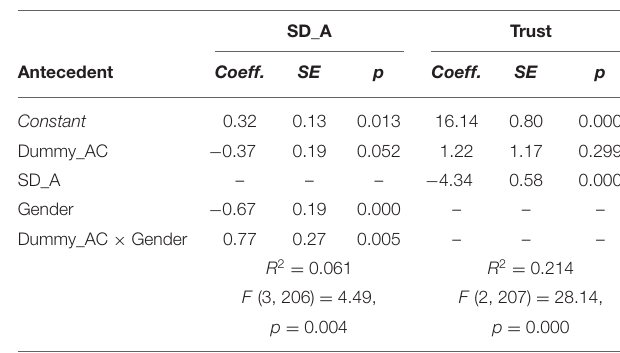
TABLE 1 | Model coefficients for conditional indirect effect of the experimental condition on trust through perceived social distance in Study